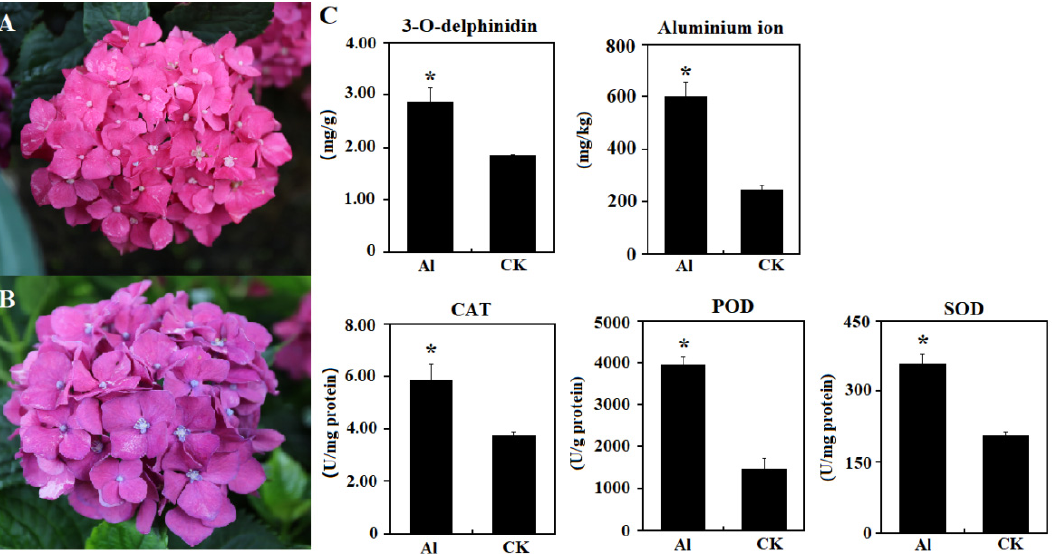
Figure 1. Phenotypic and biochemical responses to aluminum stress by Hydrangea macrophylla . Hydrangea macrophylla under normal conditions ( A ) and Al 3+ stress ( B ). The asterisk (*) represents a significant difference betweent normal conditions and Al 3+ stress ( p < 0.05)